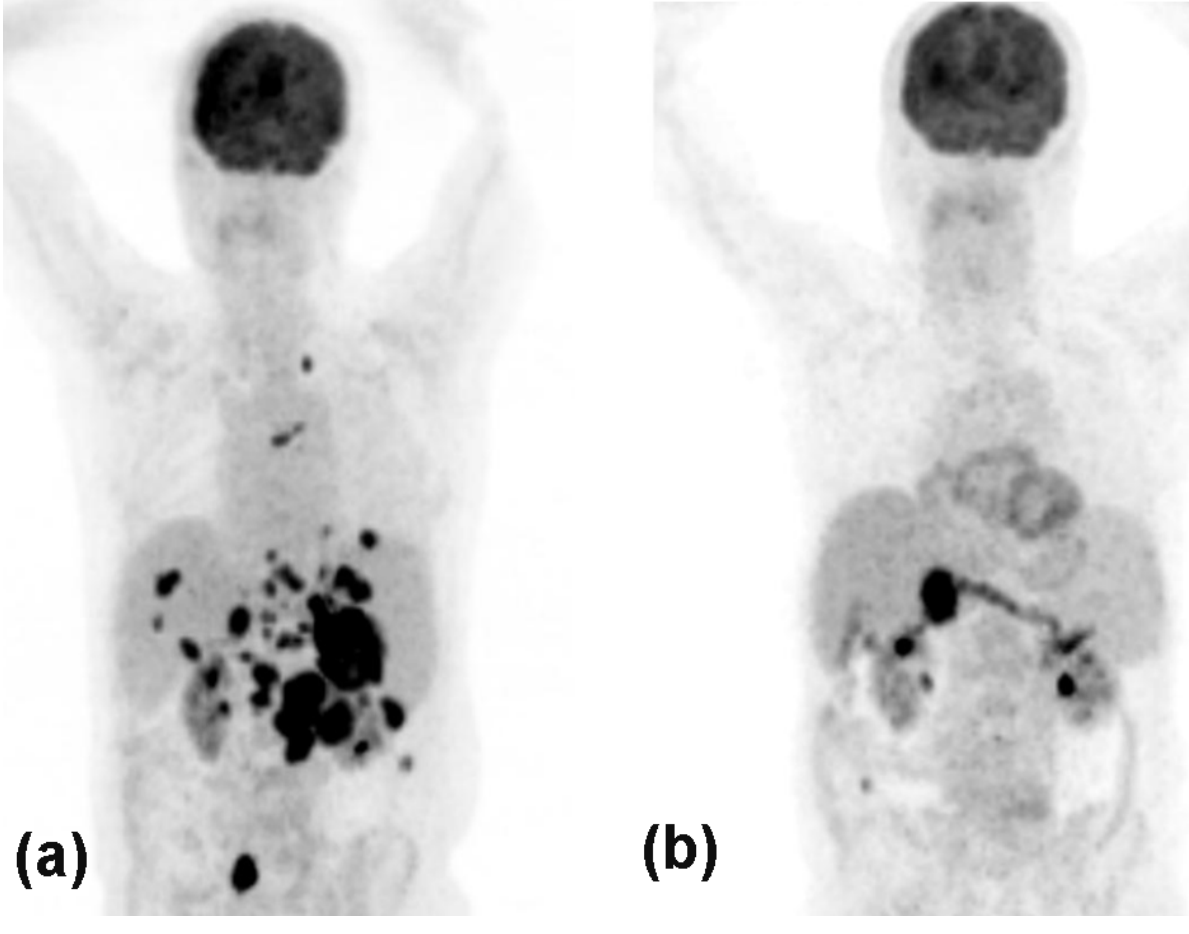
Figure 3. PET-CT of an 80-year old male showing massive melanoma metastases in the entire abdomen ( a ), which almost completely resolved after two cycles of anti-PD-1 plus an-ti-CTLA-4 combination therapy ( b ).